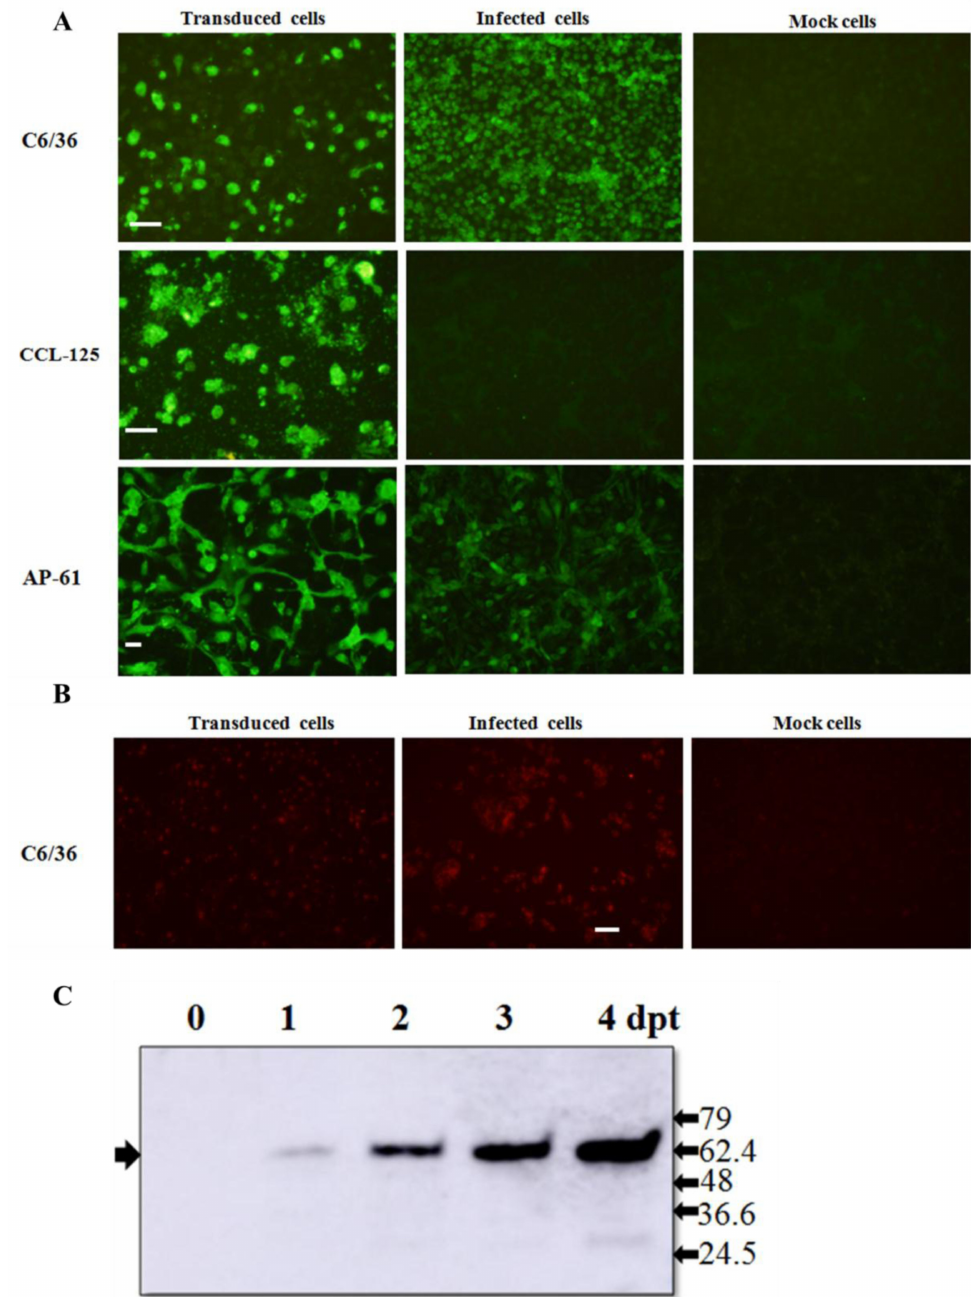
Figure 2. Expression of JEV glycoproteins in BacMos-JEV prME-transduced mosquito cells. Immunofluorescence assays for the detection of JEV E ( A ) and prM ( B ) glycoproteins. Three mosquito cells, C6 / 36 ( upper panels ), CCL-125 ( center panels ), and AP-61 ( lower panels ), were transduced with BacMos-JEV-prME ( left panels ) or infected with JEV at an MOI of 5 ( center panels ). After 5 days (transduction) or 2 days (infection), BacMos-JEV-prME-transduced cells ( left panels ), JEV-infected cells ( center panels ), and mock cells ( right panels ) were fixed and stained using Mab specific to either JEV E ( A ) or prM ( B ) glycoproteins. Cells were examined using green ( A ) or red ( B ) filters. Scale bar = 100 µ m. Western blot analysis results for the detection of JEV E glycoprotein in C6 / 36 cells transduced using BacMos-JEV-prME ( C ). Total cell lysates were harvested at indicated times (dpt) and subjected to Western blot analysis to detect JEV E glycoproteins (indicated by arrows on the left). Protein sizes (kDa) of markers are shown on the